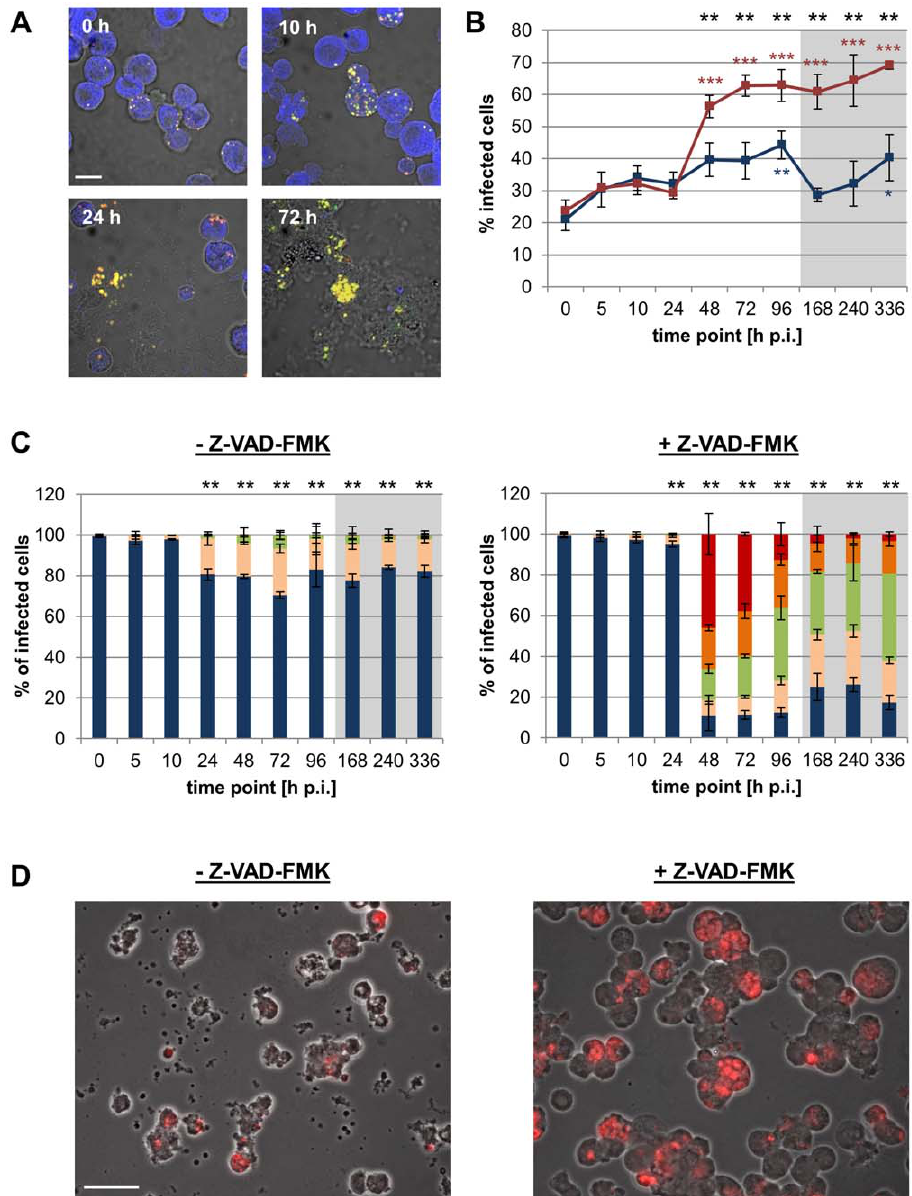
Figure 7. Effect of caspase inhibition on the infection of S2 cells with Pa.acanthamoebae . S2 cells were infected with Pa. acanthamoebae (MOI 5) and were incubated for the indicated time periods in the absence or presence of the pan caspase inhibitor Z-VAD-FMK (10 m M). Bacteria were detected with the FISH probes UV7-763 (Cy3, red) and Chls-0523 (Fluos, green), host cells with the probe EUK516 (Cy5, blue). Representative confocal images of the infection cycle (in the absence of Z-VAD-FMK) are shown in (A). The bar indicates 10 m m. The percentage of infected cells observed in the absence (blue) or presence (red) of Z-VAD-FMK over the course of infection is depicted in (B). Black stars indicate statistically significant differences between both curves (t-test) and colored stars indicate significant differences to the respective 0 h p.i. time point (ANOVA & Scheffe´). Numbers of intracellular bacteria per infected cell were determined and are shown in (C). Infected cells were classified into 5 groups according to the number of intracellular bacteria (1–3, blue; 4–10, rose; 11–30, green; 31–100, orange; . 100, red). Stars indicate statistically different distributions among these classes at a given time point between infections carried out in the absence or presence of Z-VAD-FMK ( x 2 test). In (B) and (C) mean values and standard deviations of three replicates are shown (***, p # 0.001; **, p # 0.01; *, p # 0.05). The gray boxes indicate time points that were analyzed after cells had been passaged. The microscopic images in (D) illustrate the enhanced infection of S2 cells with Pa. acanthamoebae in presence of Z-VAD-FMK at 48 h p.i. Bacteria were detected with the FISH probe UV7-763 (Cy3, red). The bar corresponds to 20 m